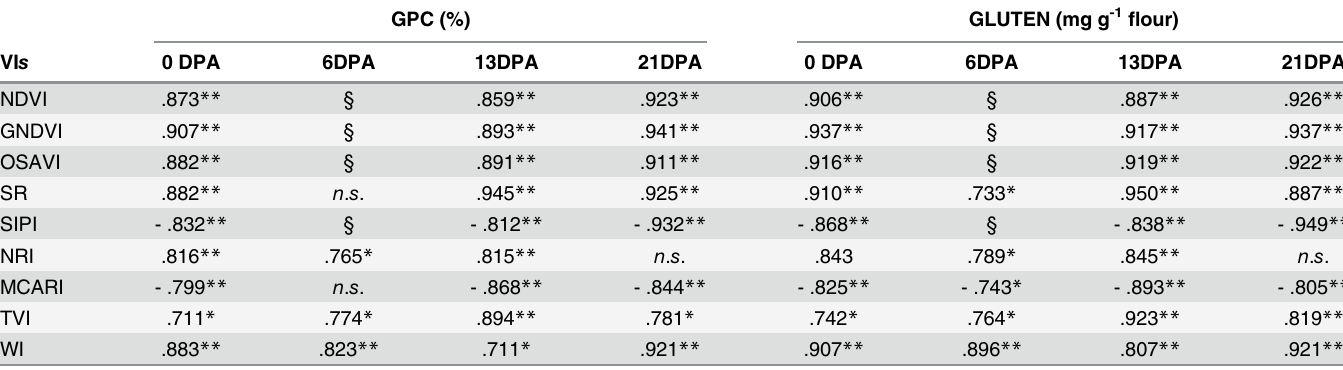
Table 2. Pearson ’ s correlation coefficients between grain protein content (GPC, %) or total gluten protein content (GLUTEN, mg g -1 flour) of durum wheat grains at harvest (DC92) and nine VI s calculated from reflectance data recorded at different growth stages, during grain-development (DC65, DC71, DC75 and DC77, corresponding to 0, 6, 13 and 21 days post-anthesis (DPA)) in 2012.